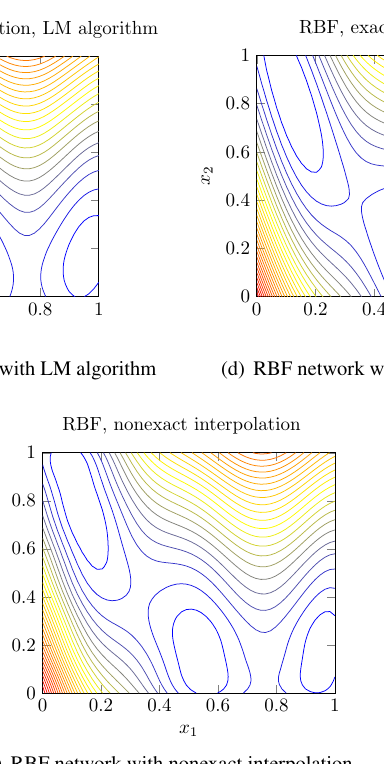
Figure 2. Test function and the